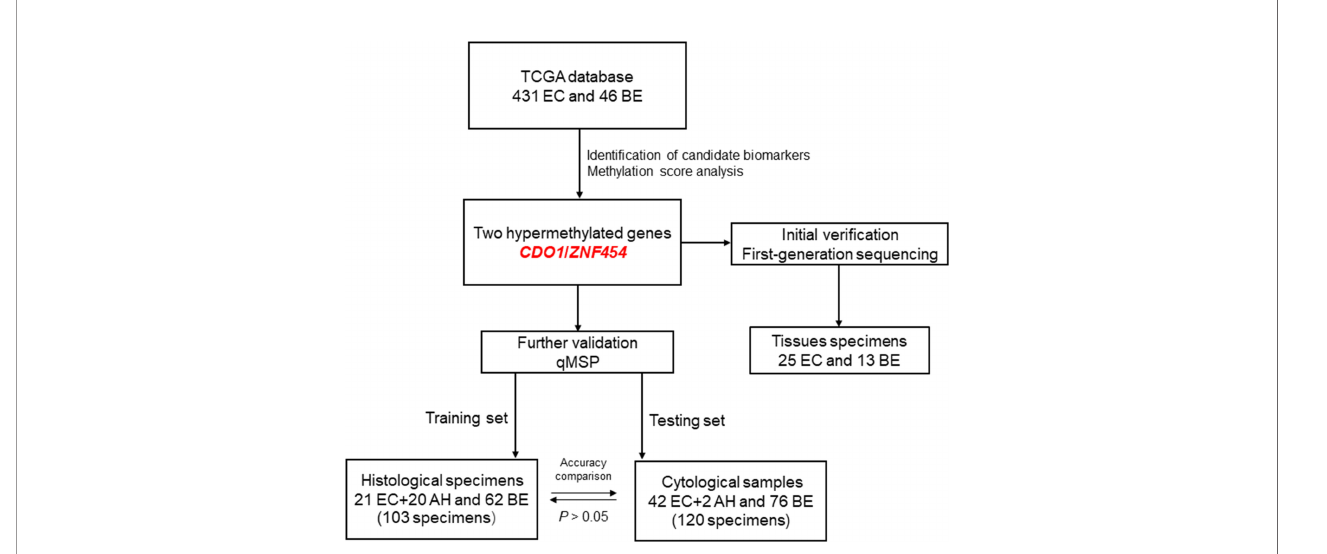
FIGURE 5 | The fl ow chart of this study. EC, endometrial cancer; BE, benign endometrium; AH, atypical hyperplasia; qMSP, quantitative methylation-speci fi c polymerase chain